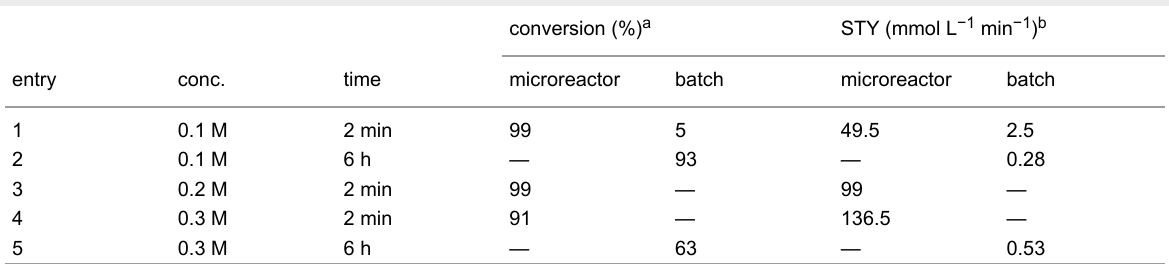
Table 2: Photosensitized oxygenation of ( − )-citronellol.